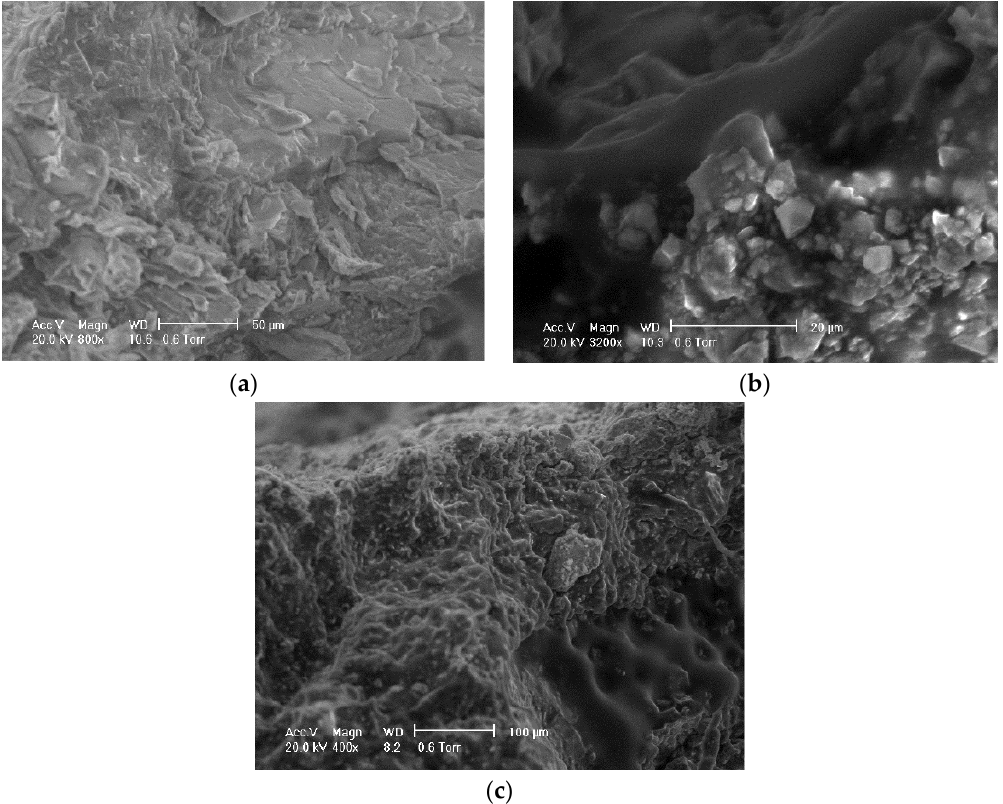
Figure 22. Scanning electron microscope (SEM) method: ( a ) cement stone; ( b ) interface between cement stone and asphalt; ( c ) bituminous mixture particles bond to cement.